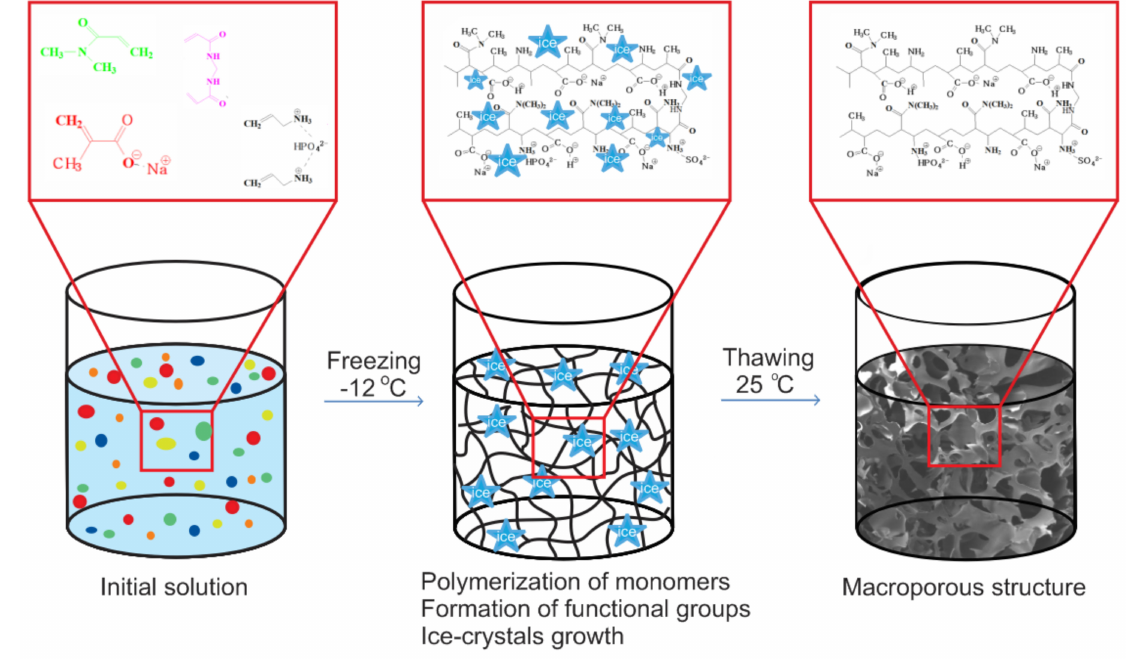
Figure 1. Schematic representation of the formation of p(MAAc)-DMAAm-AA